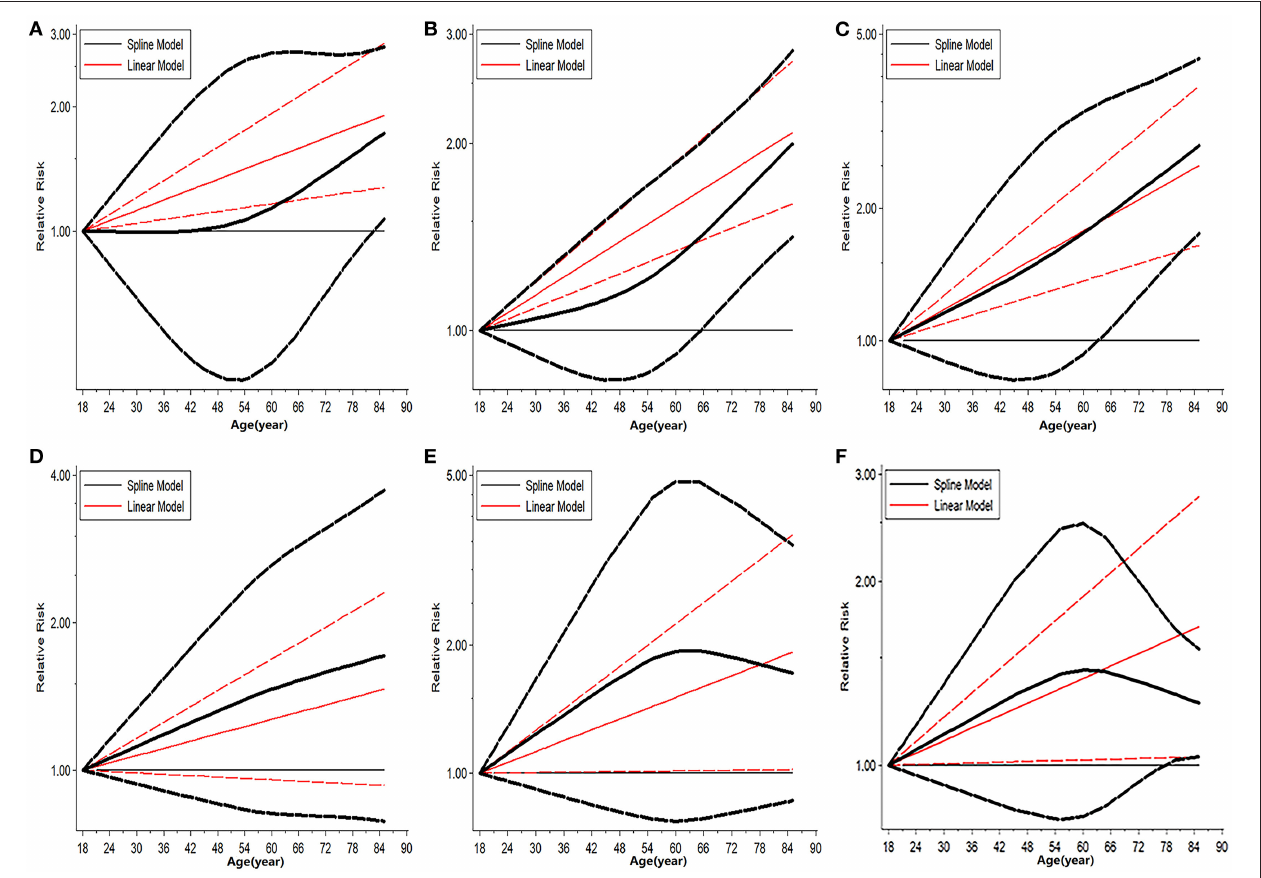
FIGURE 5 | Dose-response analysis on risk of advanced donor age on patient death. (A) Dose-response risk of advanced donor age on 90-day patient death. (B) Dose-response risk of advanced donor age on 180-day patient death. (C) Dose-response risk of advanced donor age on 1-year patient death. (D) Dose-response risk of advanced donor age on 2-year patient death. (E) Dose response risk of advanced donor age on 3-year patient death. (F) Dose response risk of advanced donor age on 5-year patient